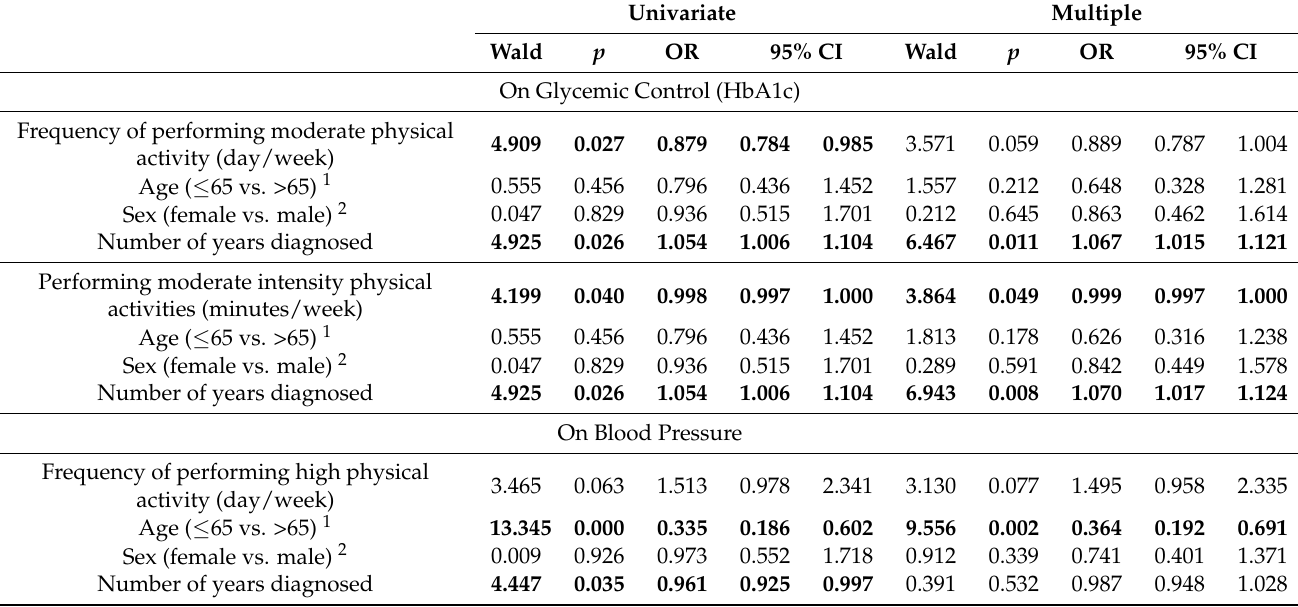
Table 4. Multiple logistic regression analysis of the association of physical activity with diabetes control in patients with T2DM. Univariate